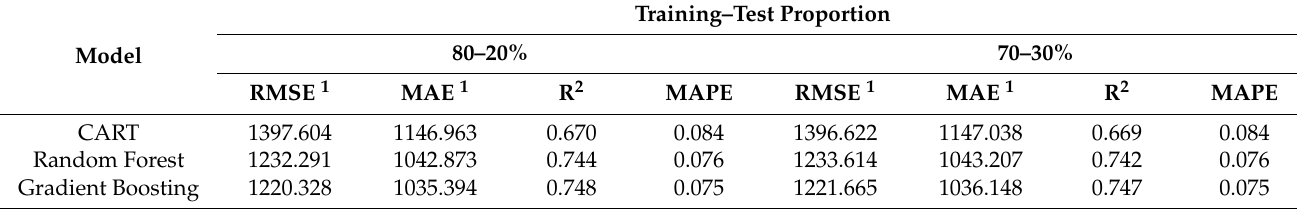
Table 5. Metrics comparison of the different regression models.